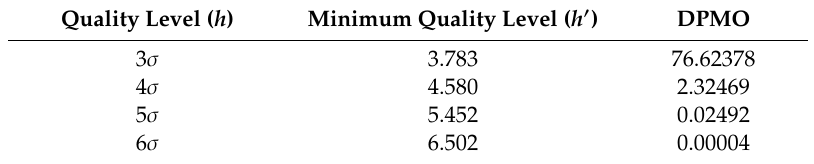
Note: DPMO: defects per million opportunities.